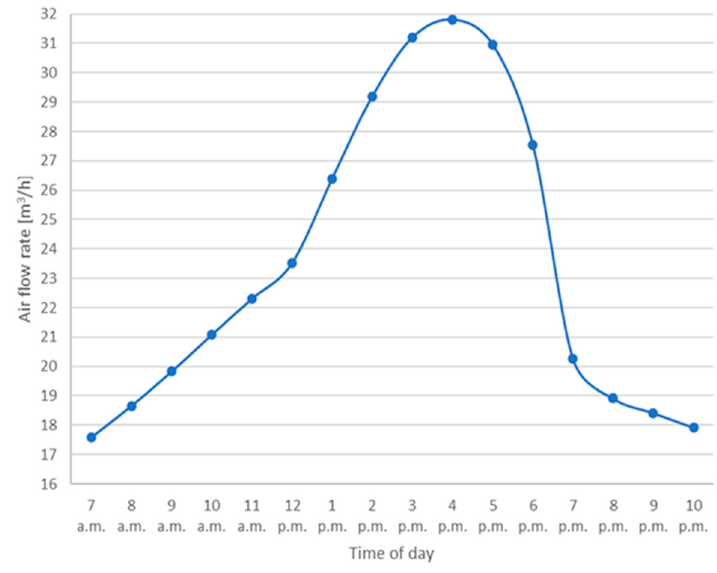
Figure 7. Hourly air flow rate through the naturally ventilated cavity.